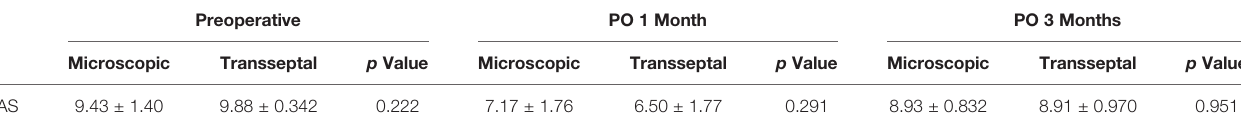
TABLE 5 | Olfactory function based on VAS.